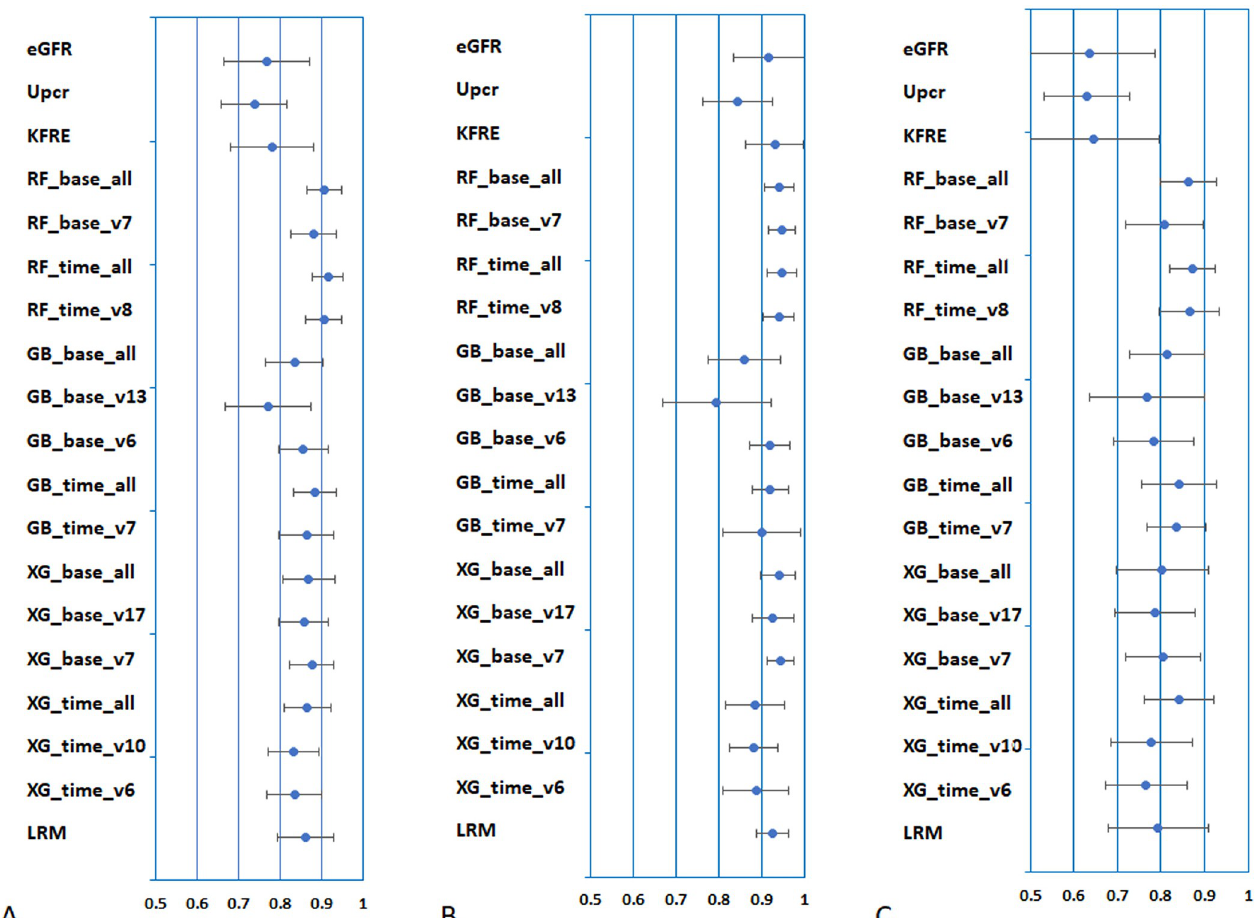
Fig 1. Model performances for prediction in outcomes over 1 year at model selection stage. Figures show the C-statistics for the prediction of outcomes with 95% CIs of the models. A: Primary outcome. B: ESKD. C: Death. Abbreviations: ESKD, end-stage kidney disease; eGFR, estimated glomerular filtration rate; UPCR, urinary protein-to-creatinine ratio; KFRE, kidney failure risk equation; RF, Random Forest; GB, Gradient Boosting Decision Tree; XG, eXtreme Gradient Boosting; LRM, logistic regression model; CI, confidence interval.